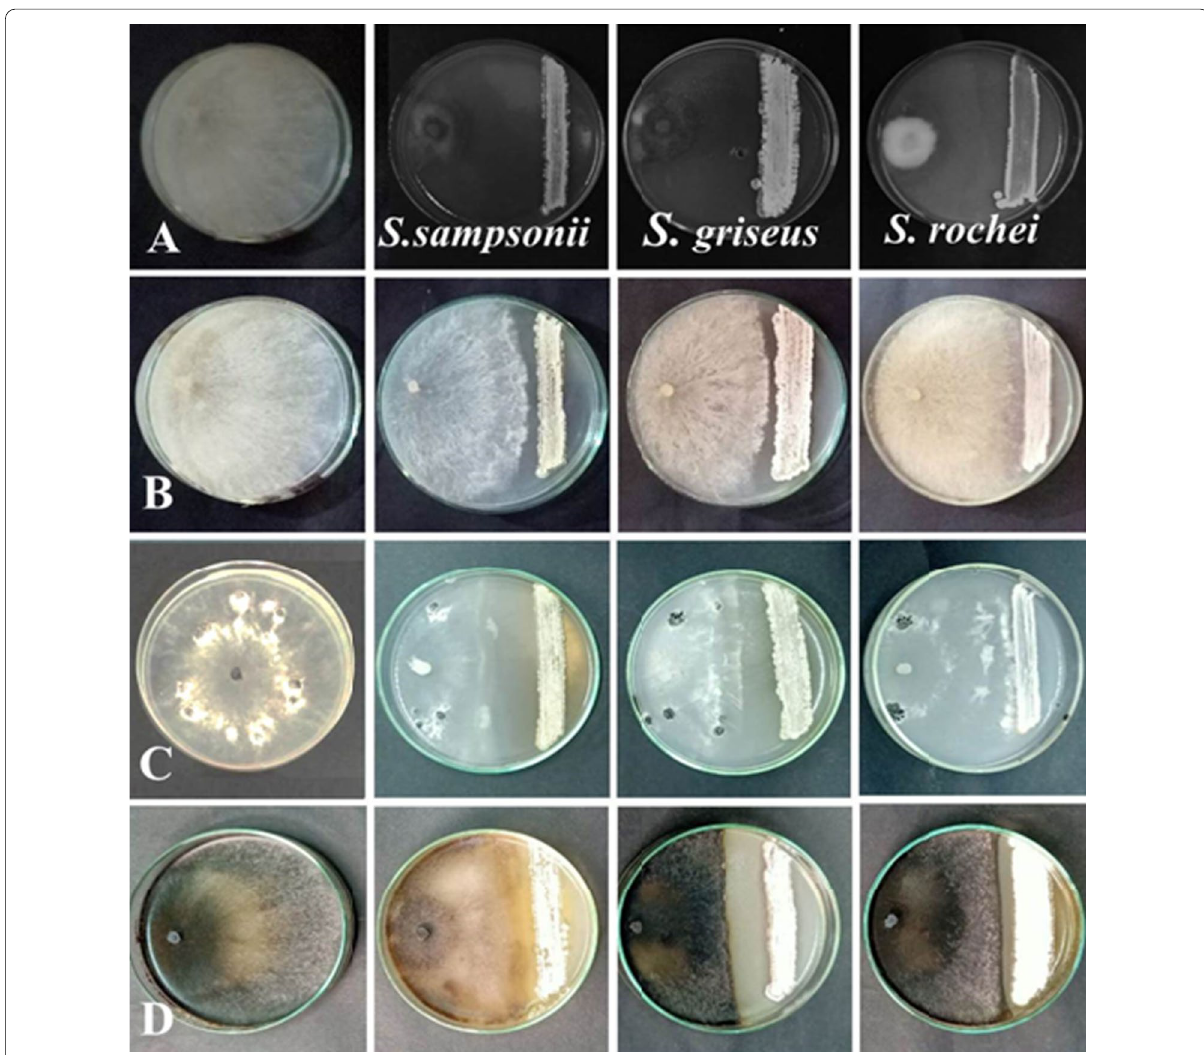
Fig. 1 In vitro growth inhibition (PGI) of various plant pathogenic fungi, B. cinerea , ( A ); R. solani , ( B ); S. sclerotiorum ( C ) and M. phaseolina ( D ) using three Streptomyces